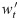
Overview of the proposed model.The model expresses an artificial EMG signal zt at t, based on a process involving white Gaussian noise wt′ passed through a shaping filter H and variance σt2. Variance σt2 is the value at t of a random variable σ2 having a distribution determined by a commanded muscle force component of variance σ¯2 and signal-dependent noise ε according to the commanded muscle force F¯.